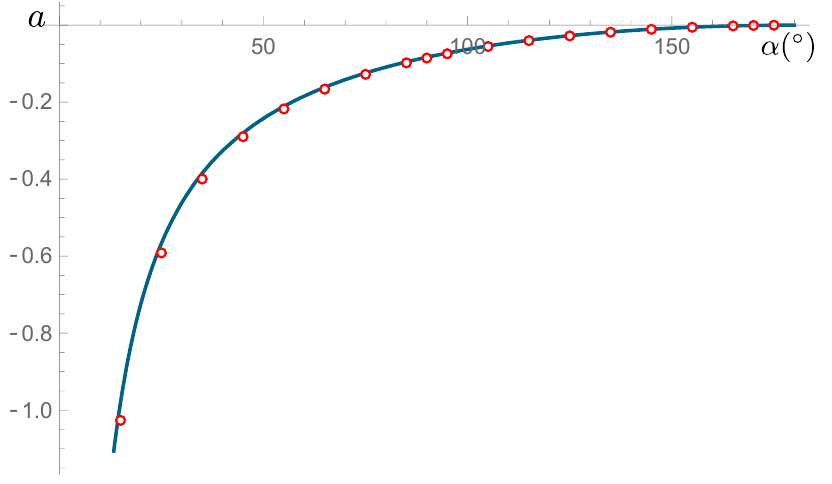
Figure 3 . Plot of the corner contribution to entanglement entropy from a single corner a ( α ) in equation (7.19) (in blue solid line). This is compared with the results of [54] which are red